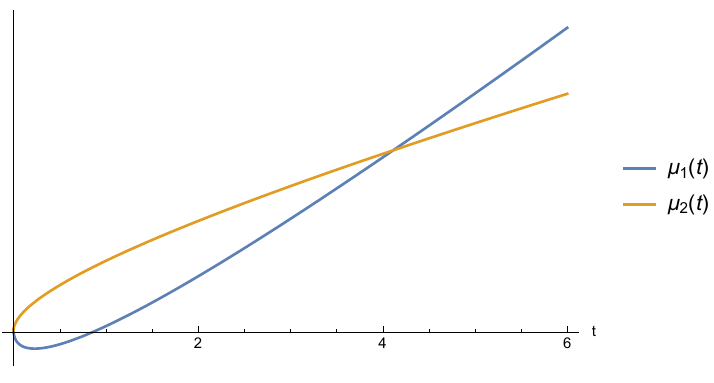
Fig. 10 The solutions of the initial value problem 40–41 for α = 0 . 5